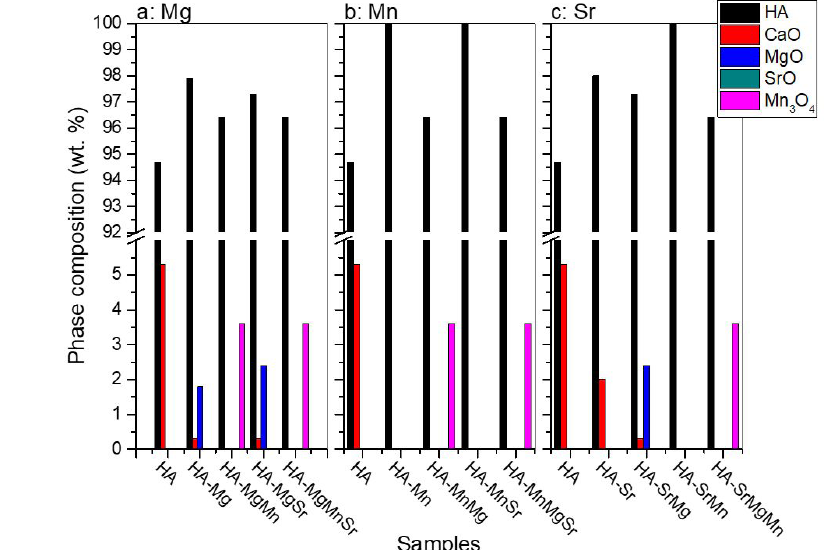
Figure 4. Phase composition of each sample after calcination at 1000°C as a function of the doping elements. The effect of Mn 2+ and Sr 2+ on Mg 2+ (a), the effect of Mg 2+ and Sr 2+ on Mn 2+ (b), and the effect of Mg 2+ and Mn 2+ on Sr 2+ (c).